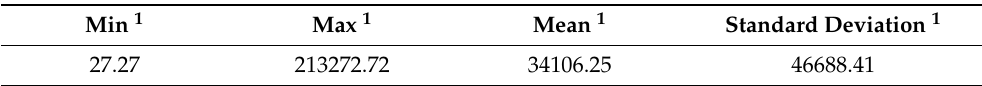
Table 2. Flow density